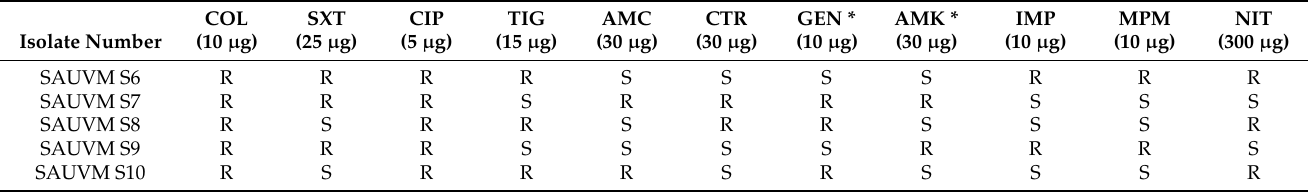
Table 3. Multidrug resistance patterns among mcr-1 positive Salmonella spp. isolates in the present study. COL